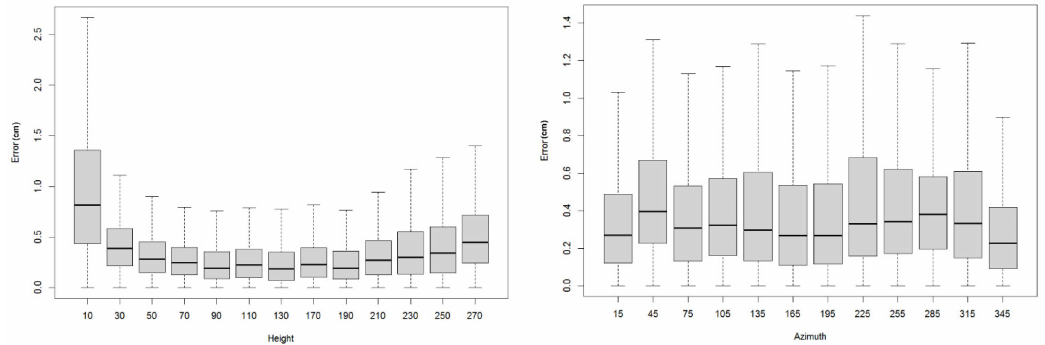
Figure 6. Error (cm) and its distribution with height ( left ) and azimuth ( right ).